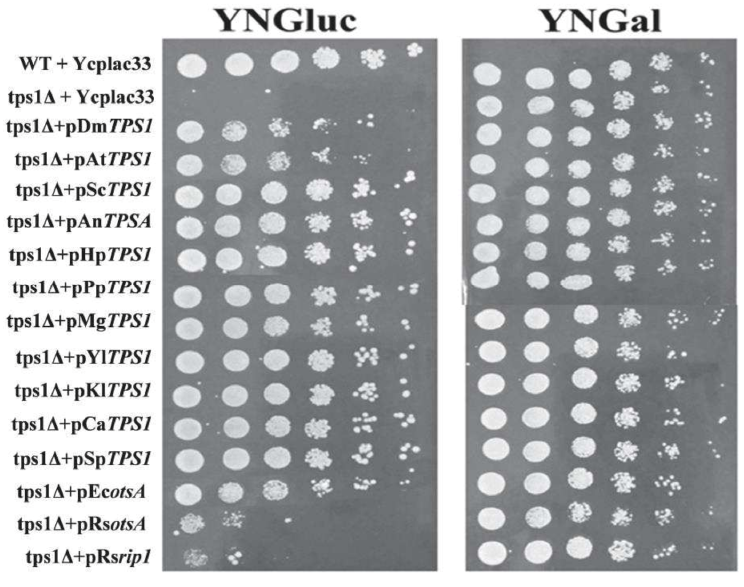
FIGURE 2 : Growth assay of S. cerevisiae tps1 Δ mutant transformed with TPS1 from different organisms on solid media. The Sctps1 Δ strain transformed with YcpLac33 plasmid bearing TPS1 homologue was cultivated on YN trehalose 1 % till 5 OD 600 units. 10 μl of serial dilution from this preculture was spotted on YN agar plate containing glucose or galactose at 2% (w/v). Growth was scored after 2 days at